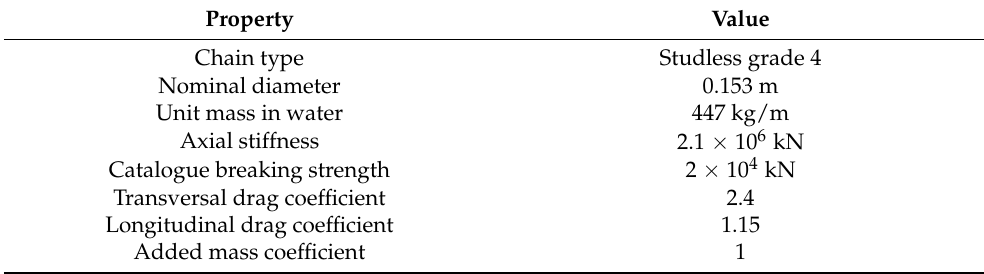
Table 4. Properties of mooring line